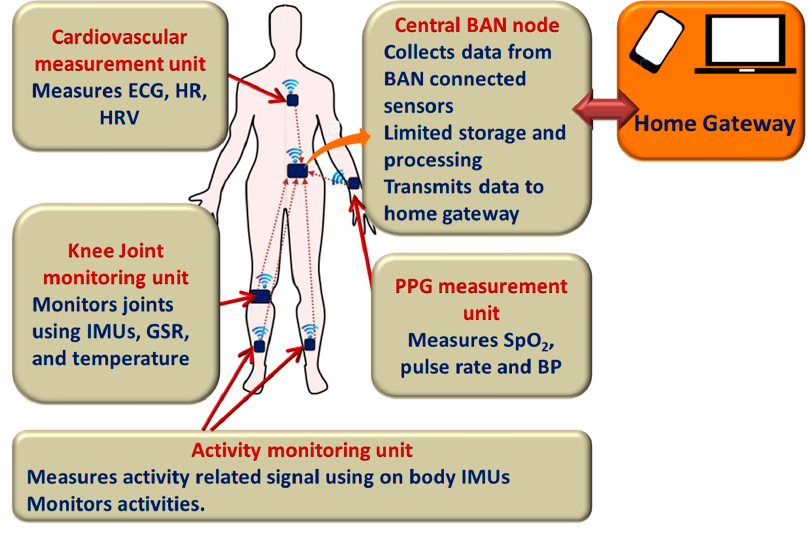
Figure 1. Wireless Body Area Network (WBAN) for wearable medical sensors.